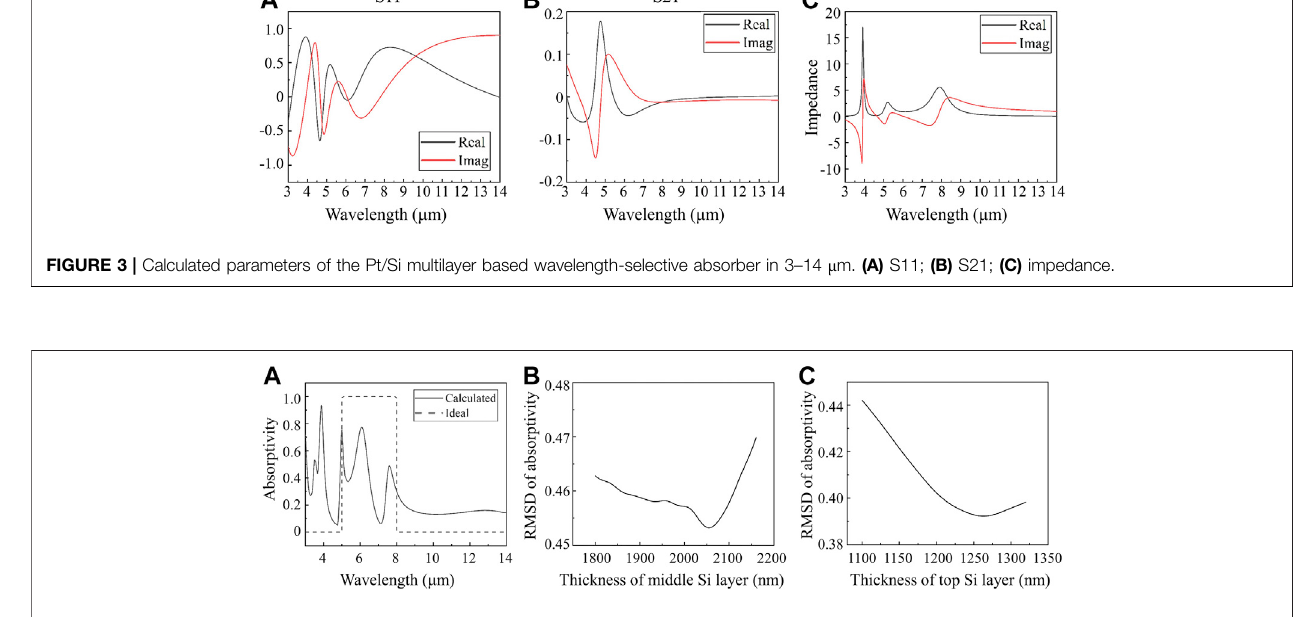
FIGURE4|(A) Absorptivityofwavelength-selective absorber.Root-mean-square deviation(RMSD) oftheabsorptivityrelativetotheideal absorber withthickness changes. (B) in the middle Si spacer; (C) in the top Si spacer.